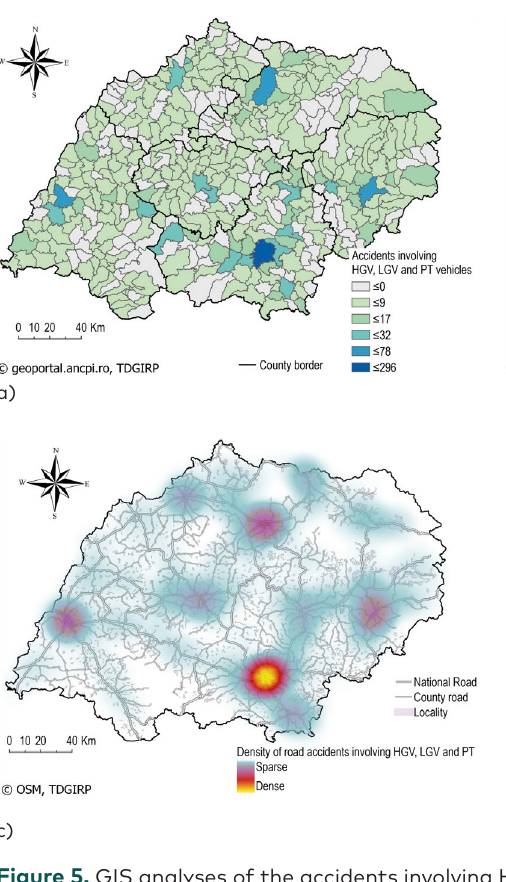
Figure 5. GIS analyses of the accidents involving HGV, LGV and PT vehicles in the North-West Region of Romania over the period between 2015 and 2018: a) sum in municipalities; b) accidents heat map; c) accidents kernel